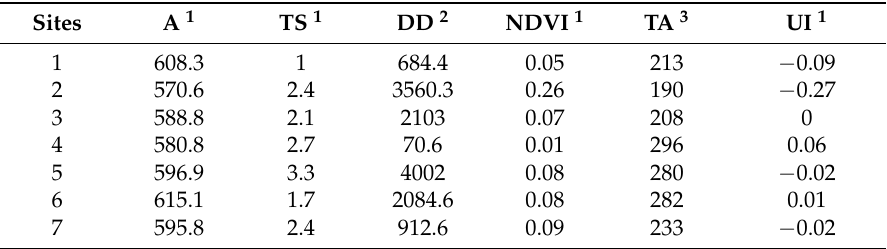
Table 1. Altitude (A), terrain slope (TS), demographic density (DD), NDVI, terrain aspect (TA), and urbanization index (UI) at the measurement sites. Sites A 1 TS 1 DD